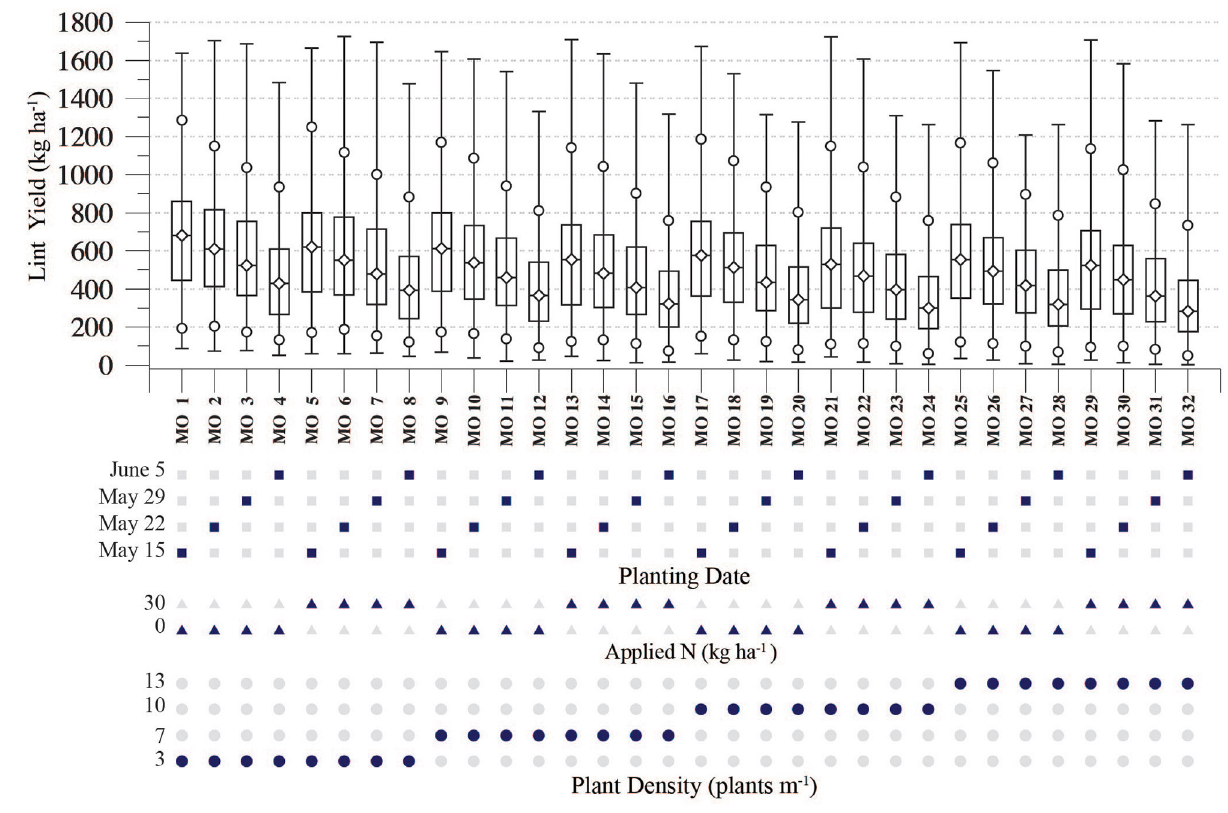
FIGURE 3 | Percentiles of simulated lint yields for each of the 32 management options, each aggregated over the 21 station’s simulations during the 11 years of 2005–2010 and 2012–2016 (21*11 = 231